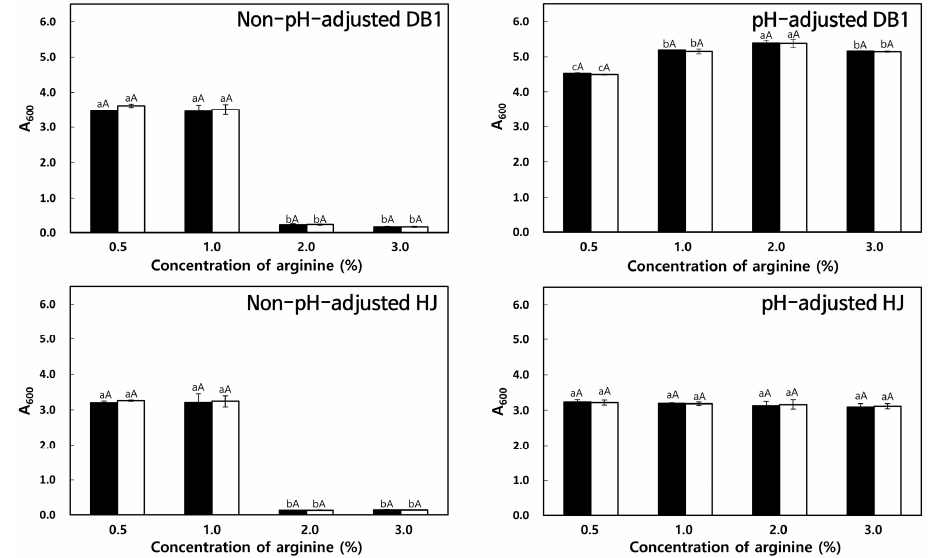
Figure 3. Effect of arginine concentration in MRS on LAB growth. W. koreensis DB1 and W. koreensis HJ were cultivated in non-pH-adjusted (left side) or pH-adjusted (right side; pH 5.0 for W. koreensis DB1 and pH 8.0 for W. koreensis HJ) MRS + 1.0% arginine for 24 h ( ■ ) or 48 h ( □ ) at 30 °C. Different lowercase letters indicate significant differences ( p < 0.05) between cultures with different arginine concentrations as determined by Duncan’s multiple range test. Different uppercase letters indicate significant di ff erences ( p < 0.05) between cultivation times as determined by the independent-samples t